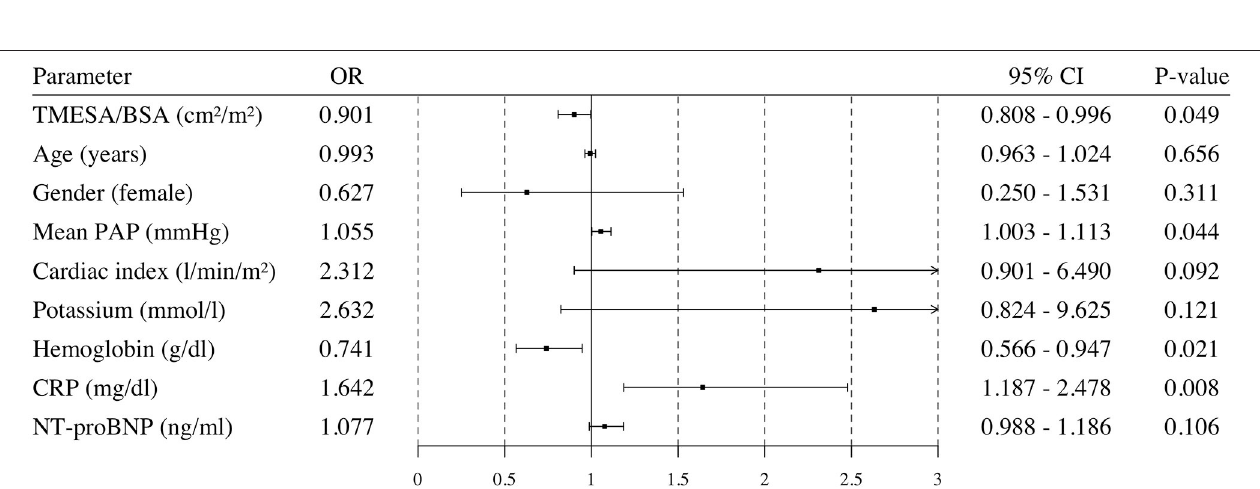
FIGURE 6 | Outcome after emergency VAD implantation during HU waiting time. VAD, ventricular assist device; LVAD, left ventricular assist device; RVAD, right ventricular assist device; BVAD, biventricular assist device; HU, ’high urgent’; T, ’transplantable’; NT, ’not transplantable.